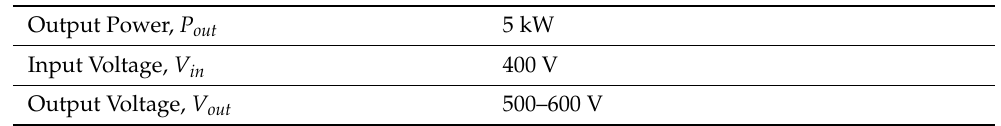
Table 2. DC-DC converter design